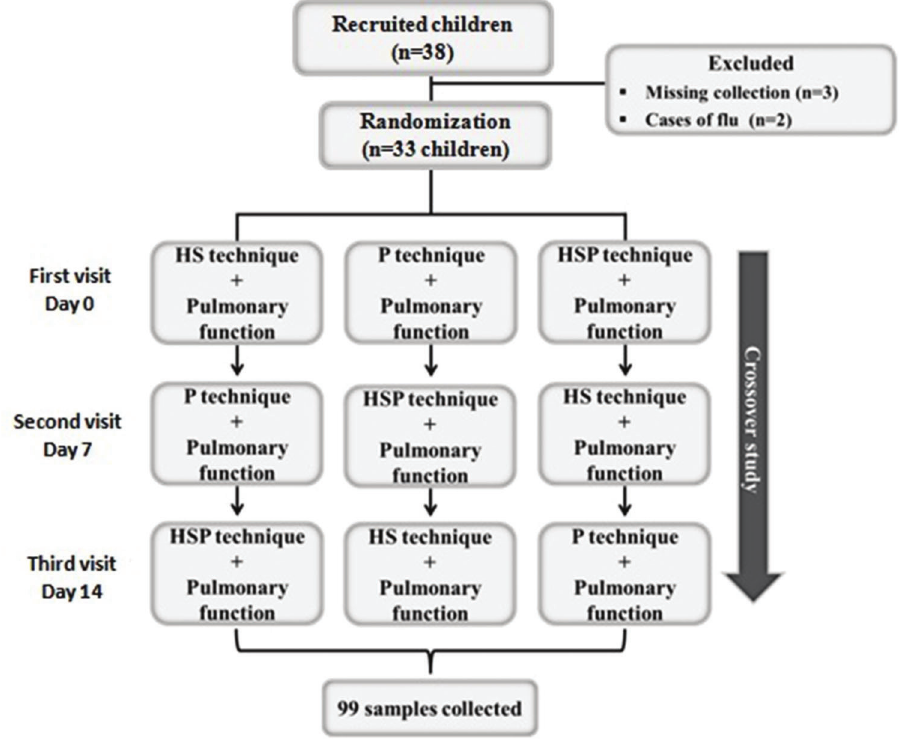
Figure 1 - Study design. Cross-over techniques of induced sputum collection. HS: hypertonic saline; P: physiotherapy; HSP: hypertonic saline + physiotherapy.